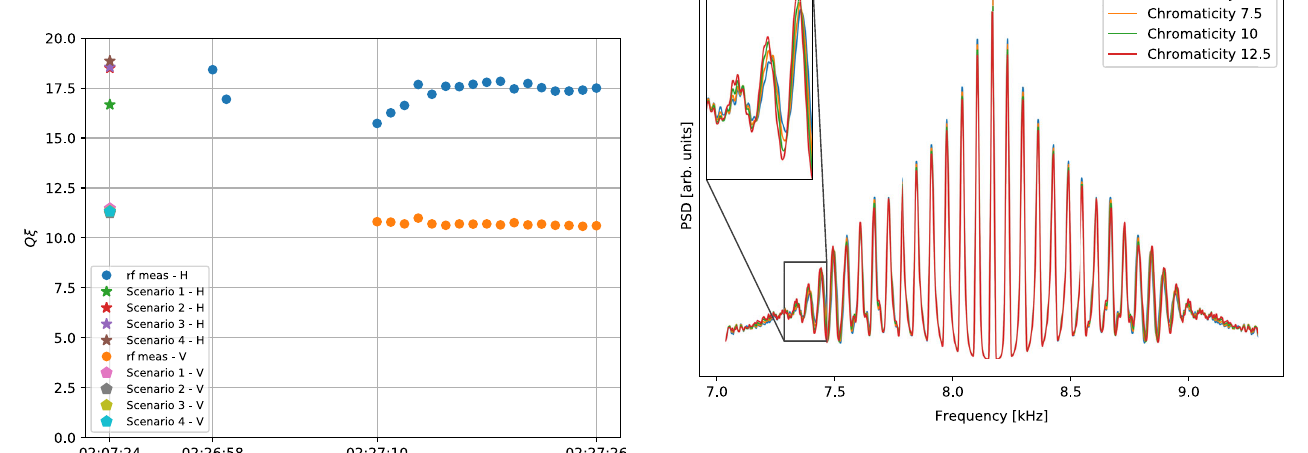
FIG. 10. Simulated lower transverse Schottky sidebands for different values of chromaticity. Bunch profile and synchrotron frequency as in fill